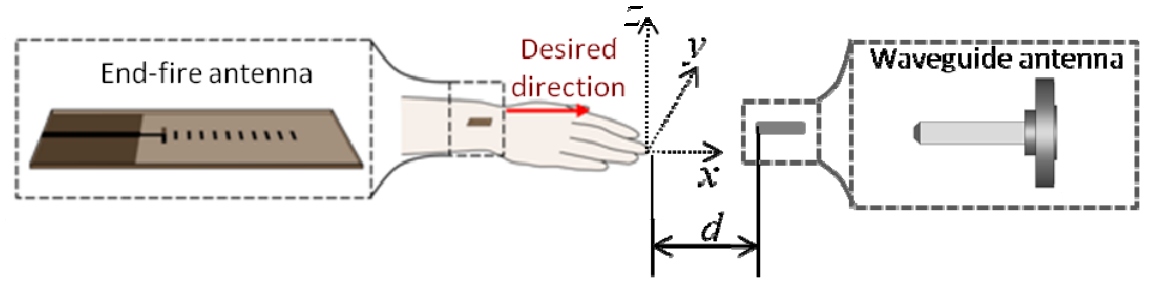
Figure 11. Wearable antenna position on a human hand and waveguide antenna placed in front of the hand as an off-body transceiver.